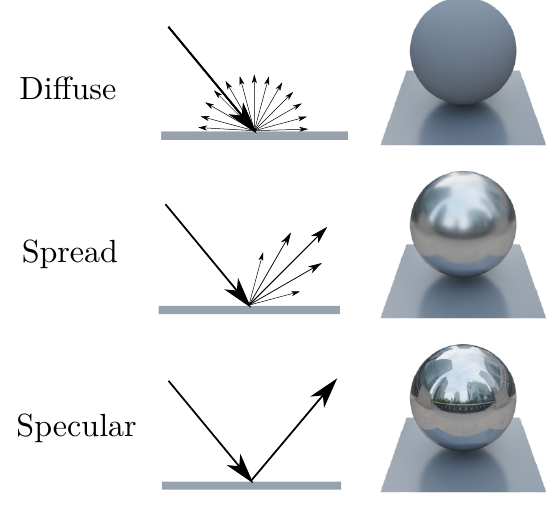
Figure 2: Basic reflection models. Diffuse reflections emit light equally in all directions, spread reflections emit in a set of directions, while specular reflections emit light in a single di-